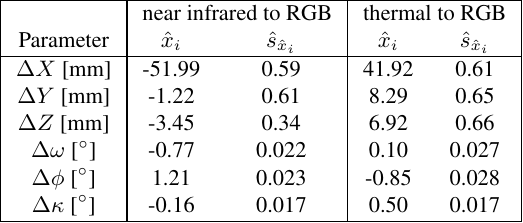
Table 3: Results of camera referencing consisting of lever arm( ∆ X , ∆ Y , ∆ Z ) and boresight angles ( ∆ ω , ∆ φ , ∆ κ ) related to the camera own coordinate system of the RGB camera (z-axis points in direction of view, x-axis points right and y-axis points down). Table 4: RMSE of marker coordinates based on image point mea- surement, external and interior orientation of near infrared as well as thermal camera.